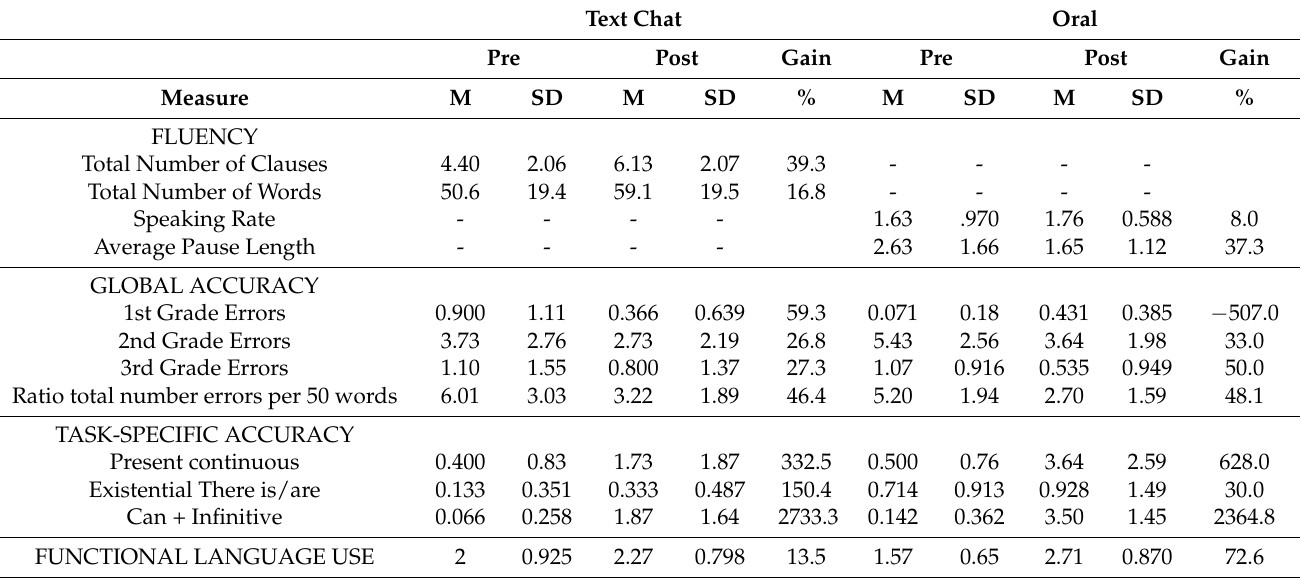
Table 2. Descriptive statistics on different linguistic measures ( N = 15).